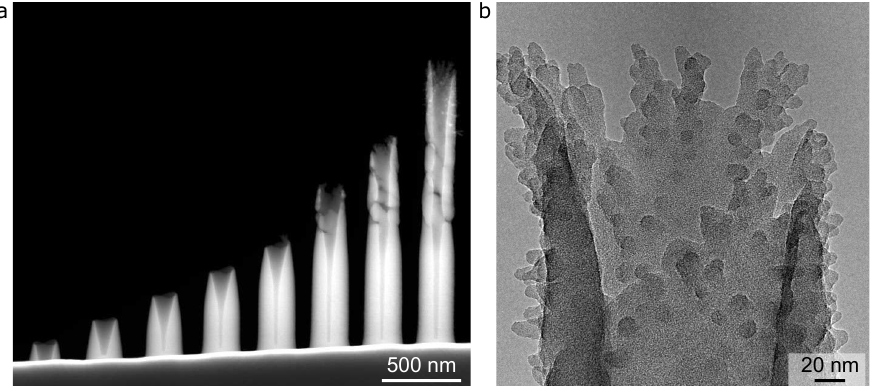
Figure 3. Insulator deposition of nanocylinders by helium FIBID (chamber pressure 2 × 10 − 6 Torr, beam current 2.5pA, copper substrate): ( a ) Dark-field STEM of a series of nanocylinders (deposition times from left to right: 7, 14, 21, 28, 35, 42, 49, and 56s). ( b ) Bright-field TEM of the apex region of the 8th nanocylinder in ( a